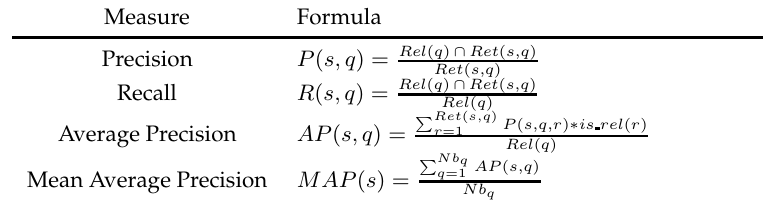
Table 1: Example evaluation